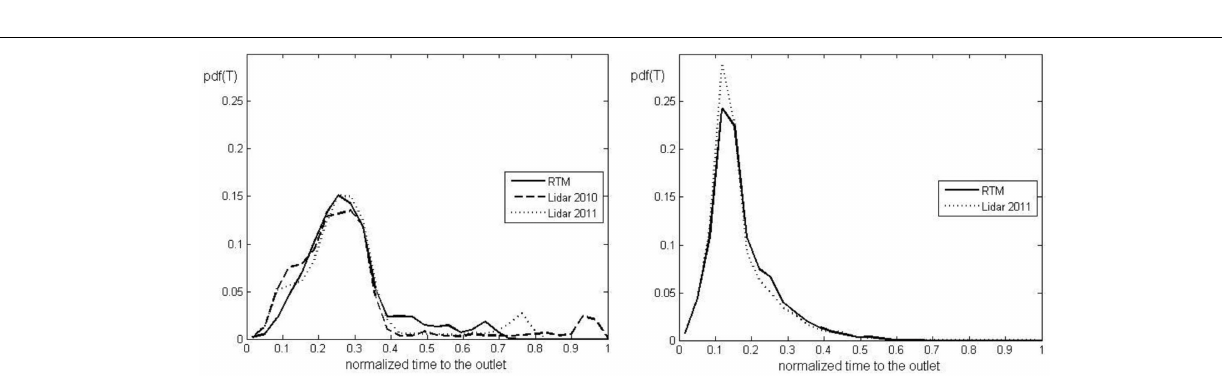
FIGURE 11 | Frequency distributions of the rescaled width function for the Dimai (left) and Cancia (right) basins (T = flow